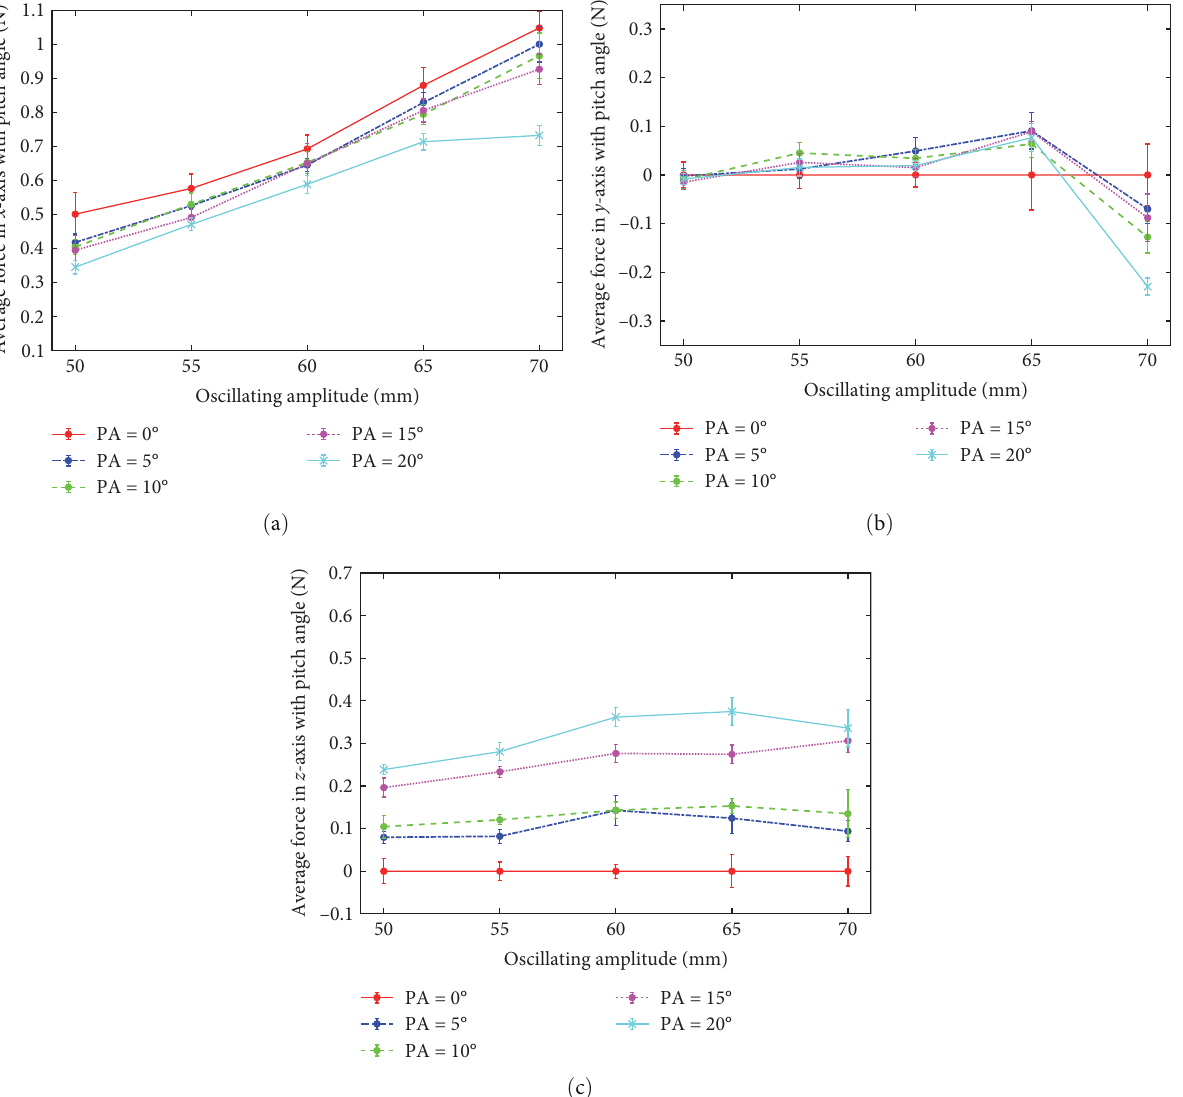
F IGURE 9: F xP ; F yP , and F zP over oscillating amplitude with no wave and no